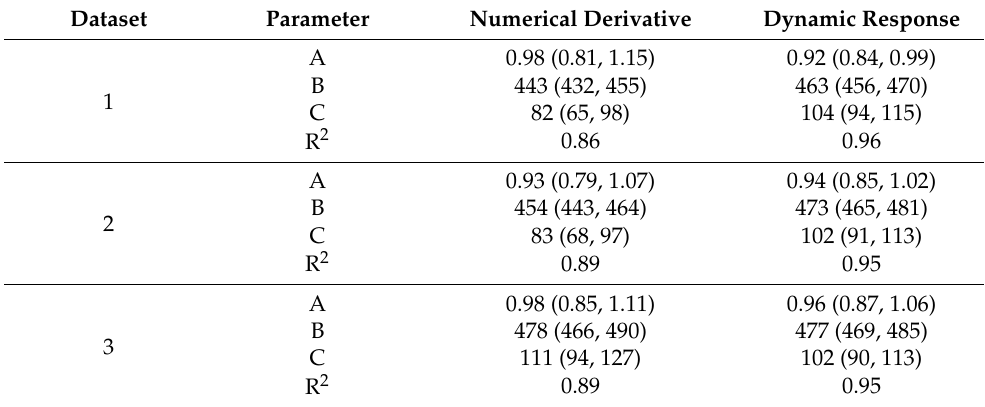
Figure 14. Comparison between the numerical spatial derivative of the static vibrometer response (red) and the measured dynamic response (black). Derivatives were calculated with a step size of 0.02. Table 2. Parameters of Gaussian fits to the numerical spatial derivative of the static vibrometer response and the measured dynamic response. Coefficients are provided with 95% confidence bounds according to equation y = a x e (((x-b)/c)^2) .